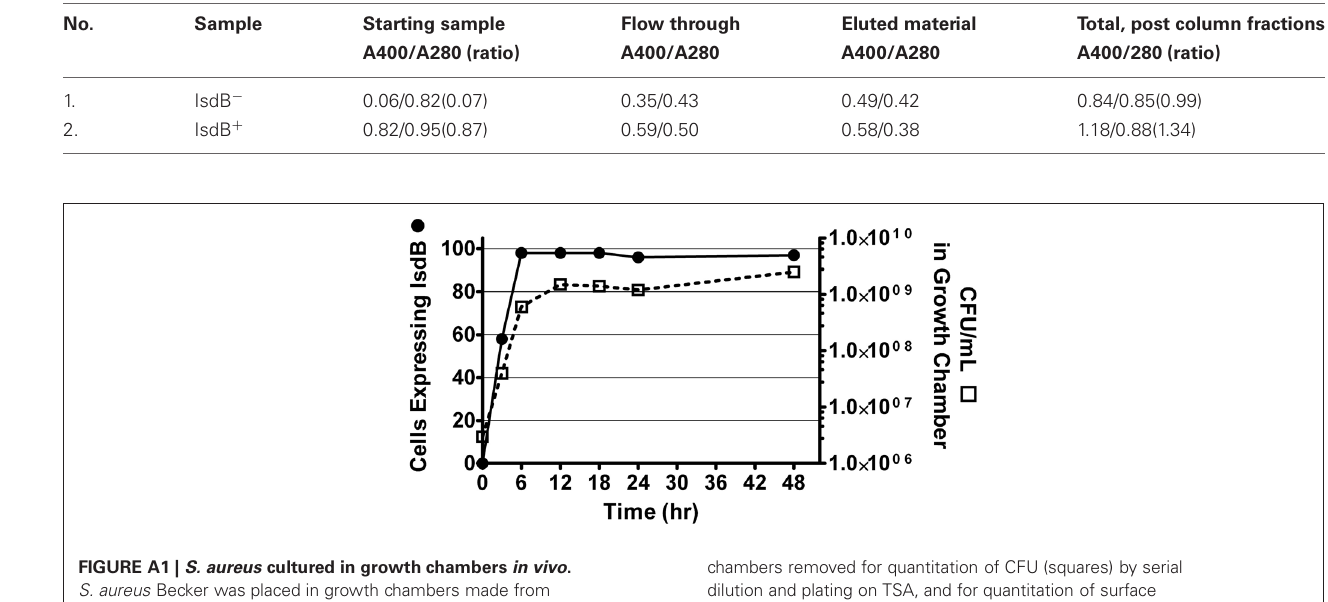
FIGURE A1 | S. aureus cultured in growth chambers in vivo . S. aureus Becker was placed in growth chambers made from dialysis tubing aseptically placed under the skin of rats. At designated times, rats were sacrificed and growth